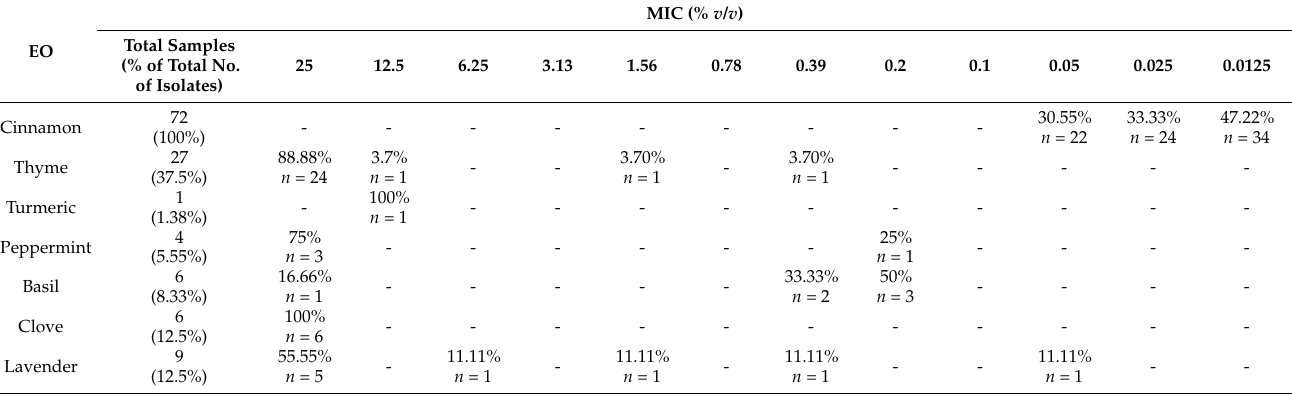
Table 2. Summary of MIC testing on clinical isolates of P. aeruginosa